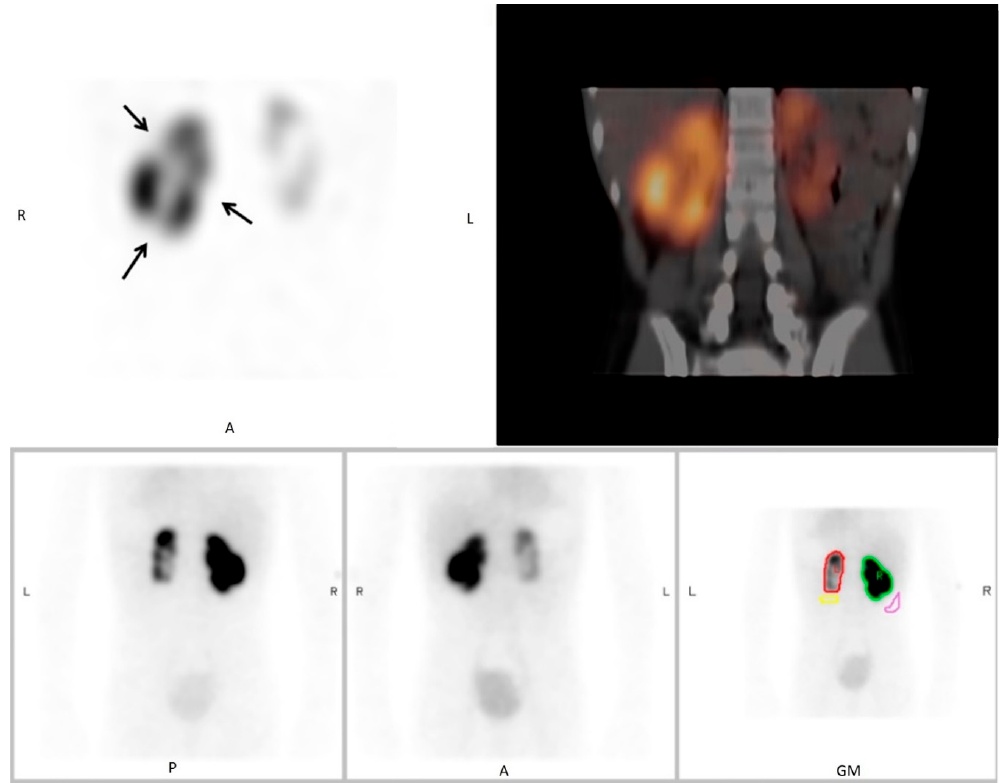
Figure 2. 99m Tc-DMSA scintigraphy as planar scan and SPECT/low-dose CT (SPECT/ldCT) in a 10-year-old girl. Evaluation scan conducted 3 months after pyelonephritis. Planar scintigraphy shows